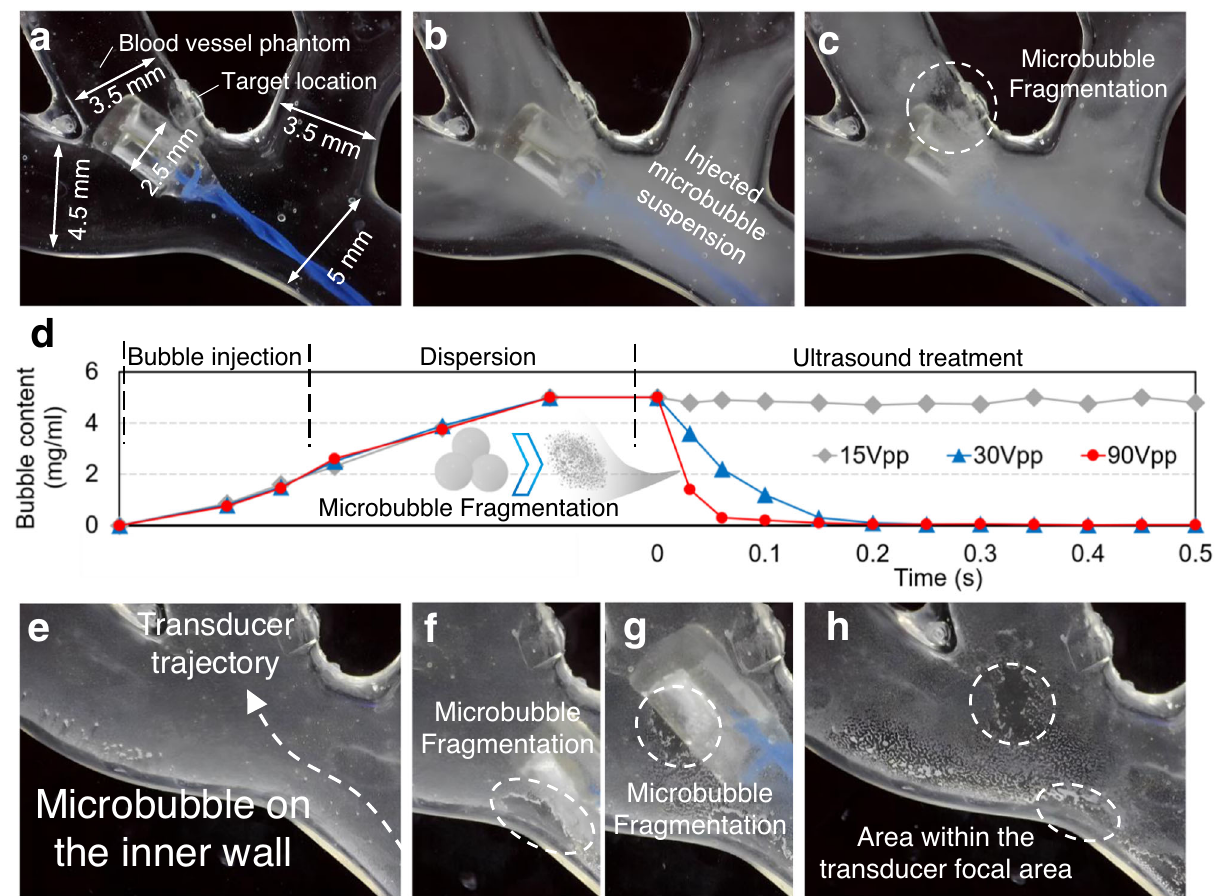
Fig. 5 | Miniaturized ultrasound transducer-induced localized cavitation in blood vessel phantom. a – c Ultrasound-induced microbubble fragmentation via our 3D printed miniaturized ultrasound transducer in a 3D printed blood vessel